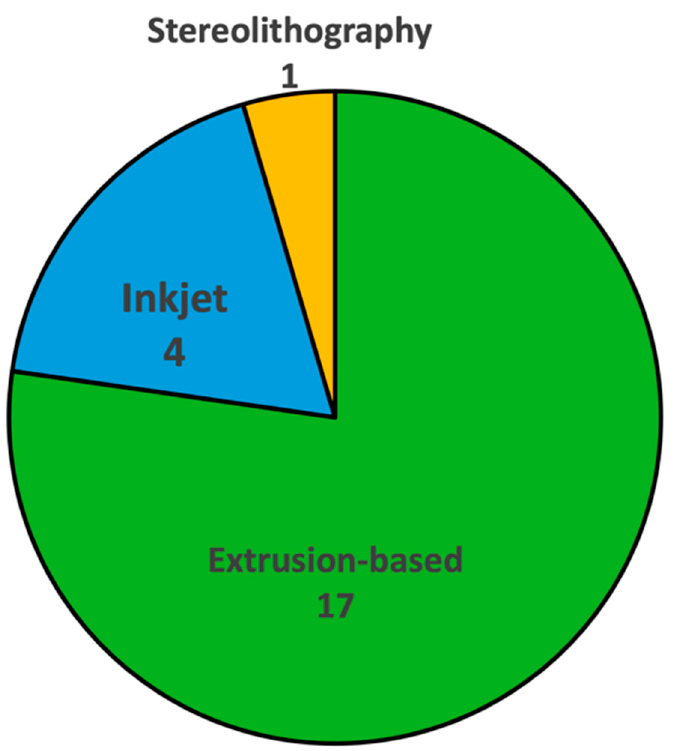
Figure 2. Utilization of bioprinting techniques for fabricating organ-on-chip systems in reviewed studies.